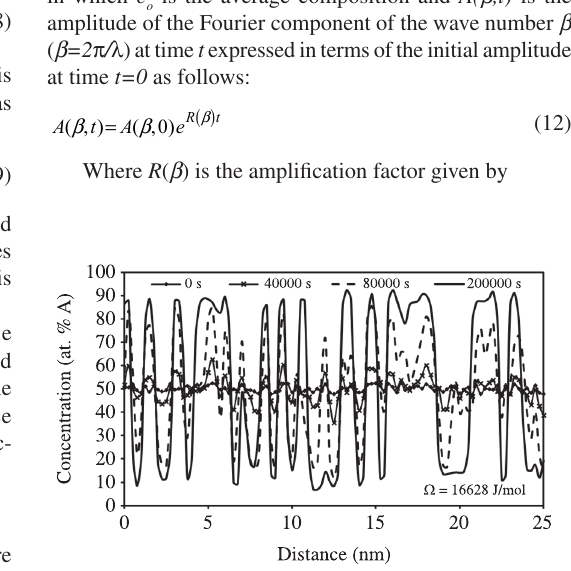
= 16628 J/mol. A-B